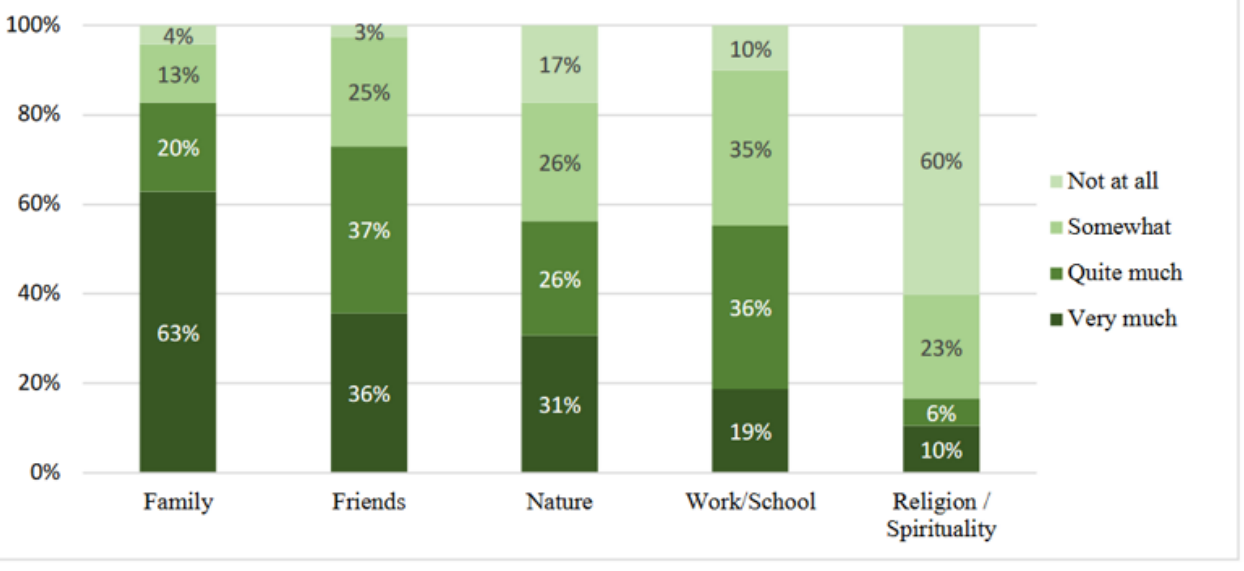
Figure 1. Meaning-giving and social/collective resilience during COVID-19, by percentage.